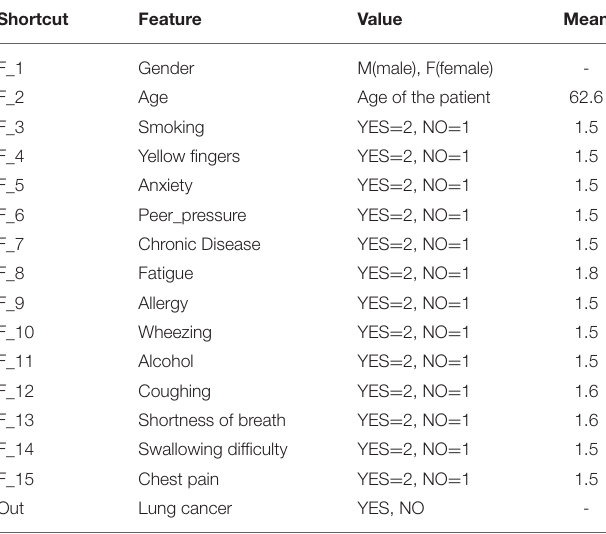
TABLE 4 | A list of features found in the lung cancer dataset (Bhat, 2021).